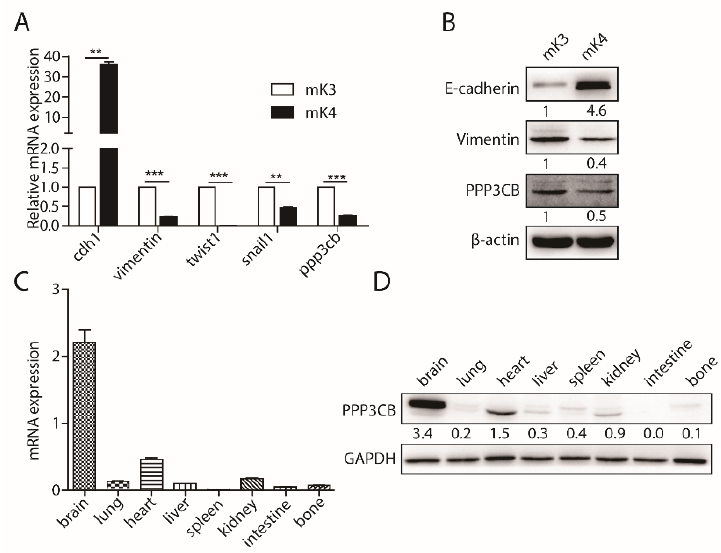
Figure 1. PPP3CB is an important regulator in kidney. ( A ) The indicated genes in mK3 and mK4 were detected by QPCR. Data represents the mean ± SEM of three independent experiments. * p < 0.05, ** p < 0.01, and *** p < 0.001. ( B ) The indicated proteins in mK3 and mK4 were detected by western blotting. ( C , D ) The expression of PPP3CB was tested in different tissues of mouse by QPCR and western blotting.